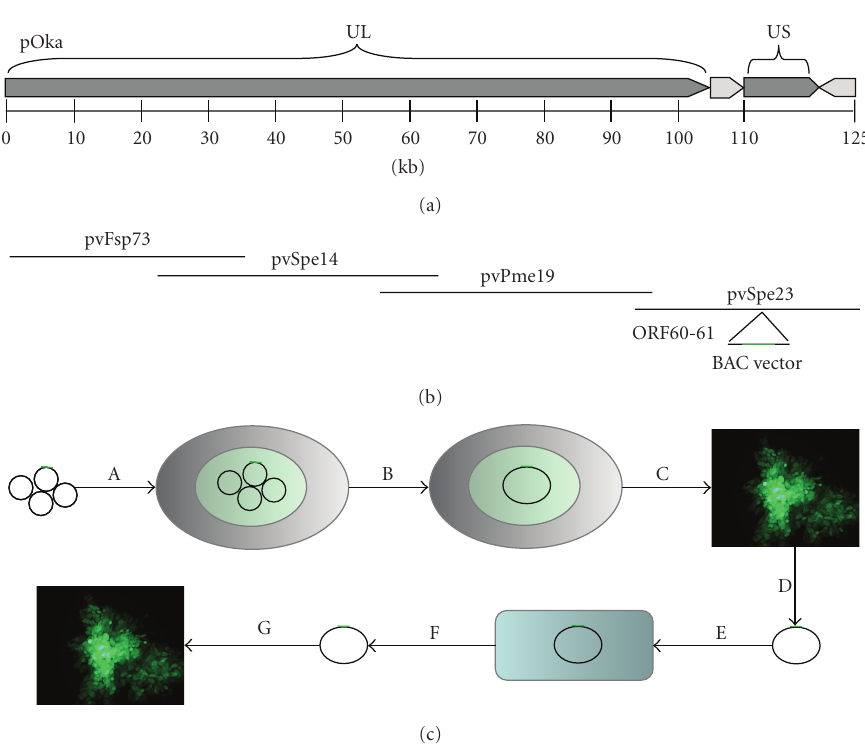
Figure 2: Construction of VZV BAC . (a) Schematic diagram of a VZV pOka genome. The 125-kb genome, VZV, contains a unique long (UL) and a unique short (US) segment. (b) Four cosmids containing overlapping VZV genomic segments are shown. A BAC vector was inserted between ORF60-61 in a VZV cosmid, pvSpe23, by homologous recombination. The BAC vector carries a GFP and a CM R marker. (c) VZV BAC construction. (A) the BAC-containing cosmid was cotransfected with the three complementary cosmids into MeWo cells; (B) homologous recombination between these four cosmids forms a circular full-length VZV genome; (C) the recombinant virus replicated and produced a green plaque; (D) the circular DNA was isolated from infected cells and (E) transformed into E. coli and selected for CMR colonies; (F) the VZV BAC DNA was isolated from E. coli and verified by restriction digestion and partial sequencing; (G) infectivity and integrity of the VZV BAC were tested by transfecting BAC DNA into MeWo cells and producing VZV